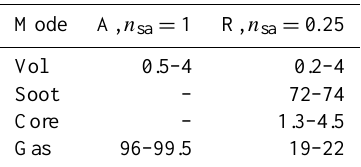
Table 2. Modeled proportions of sulfuric acid existing in different modes and remaining in the gas phase (%) at the end of the aging